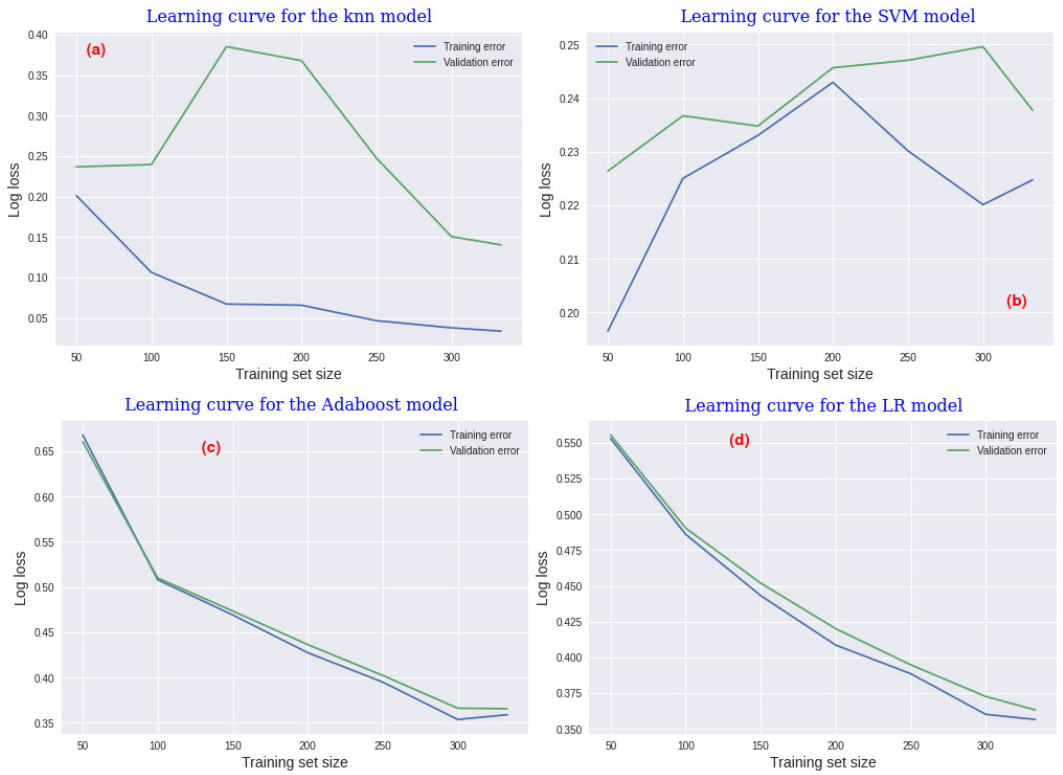
Figure 3. Learning curve finding by assessing each